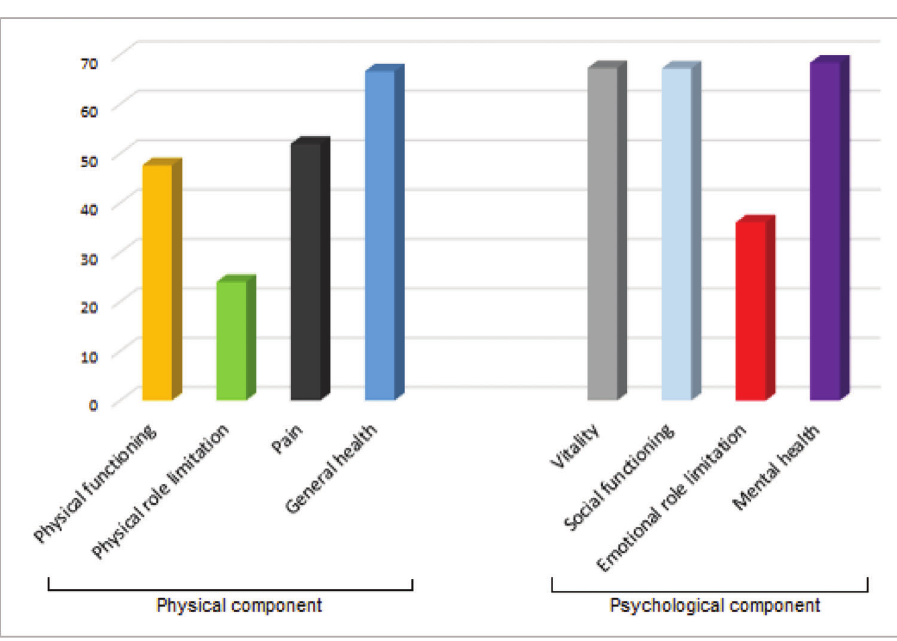
Figure 3 - Quality-of-Life scores, according to SF-36 (scored from 0 to 100; the higher the value, the lower the disability; n = 322). SF-36: Medical Outcomes Study 36-Item Short-Form Health